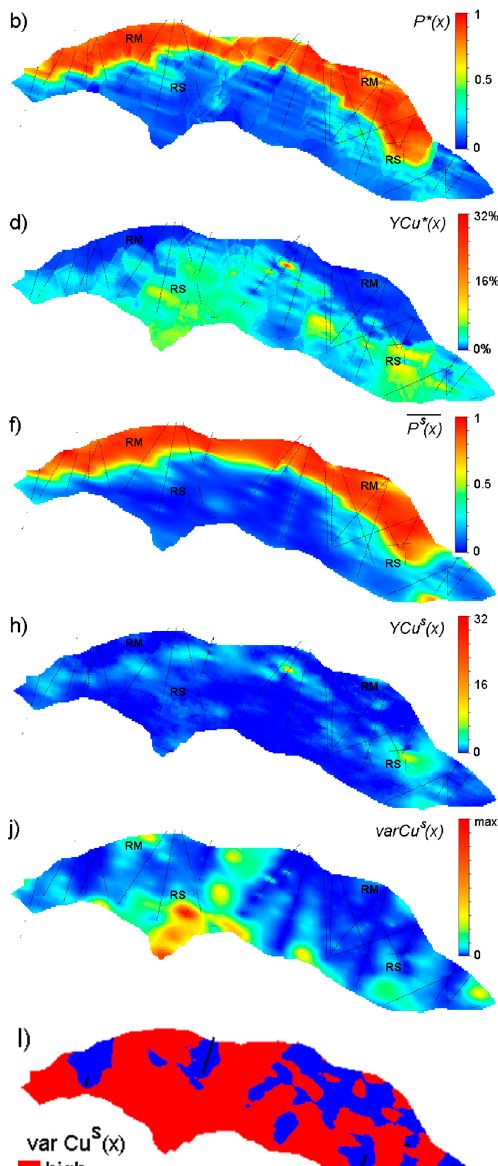
( b ) Figure 6. 3D view of ( a ) average values of proportion variable P ( x ); ( b ) average relative copper grades Y Cu ( x ) (%). From Figures 5, 6(a) and 7b,e,f, higher values of P ( x ) are located at the top of the structure, and